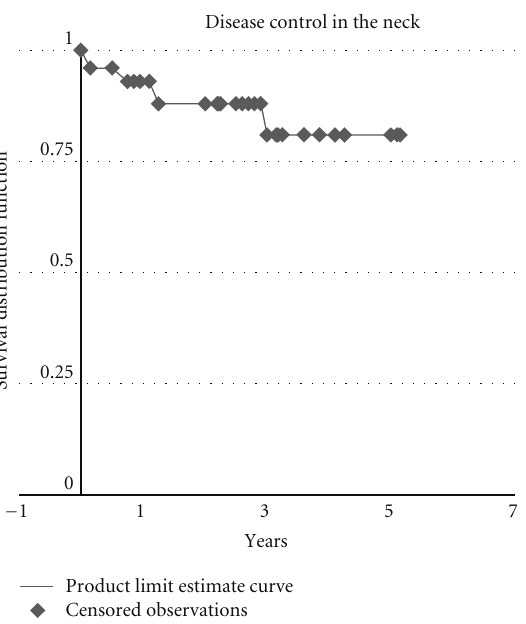
Figure 2: Disease control in the neck in advanced head and neck cancer treated with postradiotherapy neck dissection.